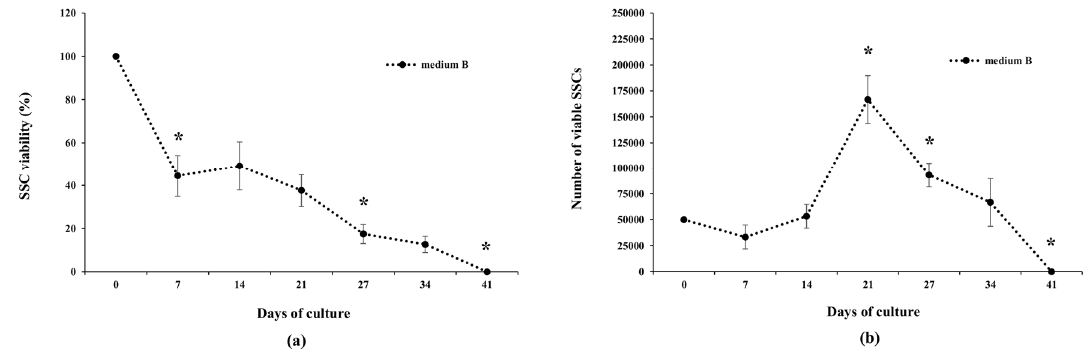
Figure 5. Viability ( a ) and proliferation rate ( b ) of meagre spermatogonial stem cells (SSCs) cultured in vitro in Medium B (modified by Lacerda et al., 2013 [22]) (Trial 2). * indicates significant di ff erence